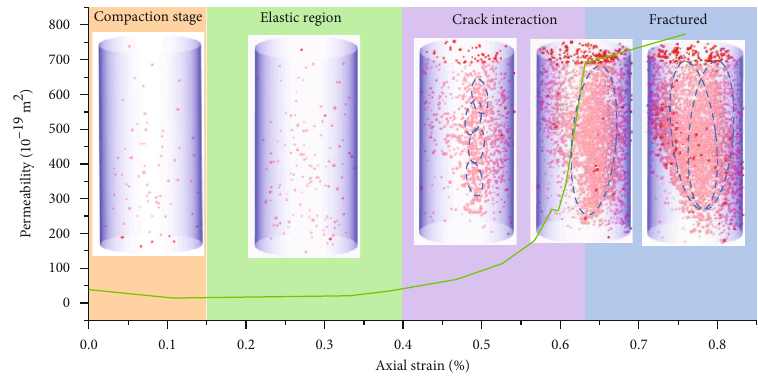
Figure 4: Evolution of AE hits at di ff erent